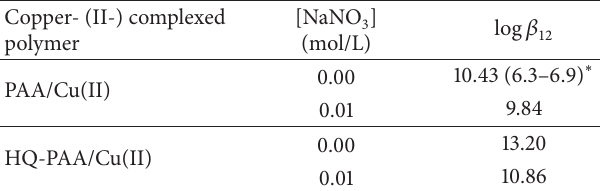
_ 𝑟= f ( p ([ HA ]/ℎ)) for HQ-PAA/Cu(II). Figure 12: Plots of Table2:Stabilityconstants 𝛽 12 ofcopper-(II-)complexedmaterials. Copper- (II-)